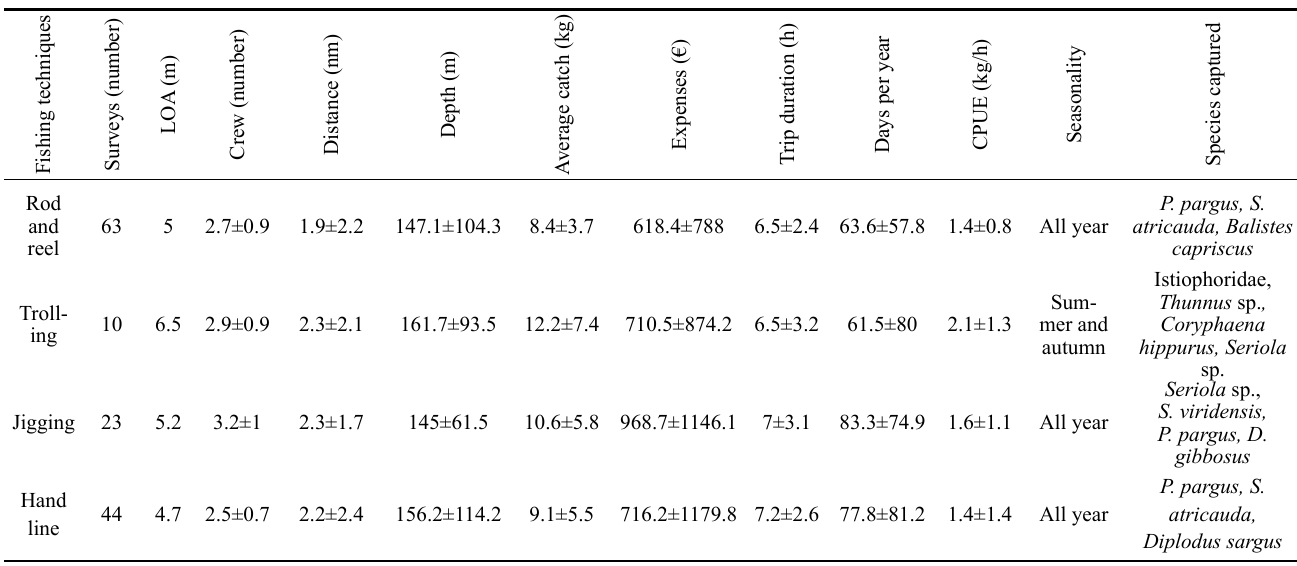
Table 2. – Recreational boat fishing techniques and characteristics (number of surveys, LOA, crew numbers, distance from the coast, fishing depth, expenses, duration of the fishing trip [hours and days per year], CPUE, seasonality and main target species). The data are shown as number or average ±SD.